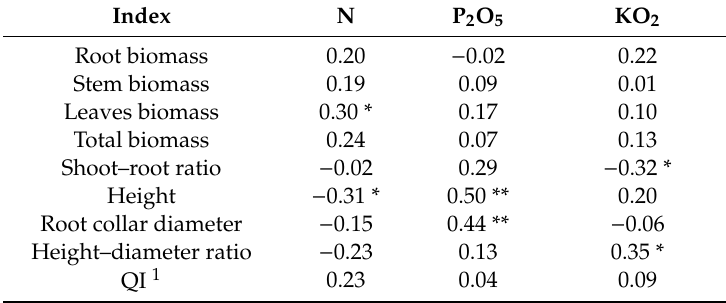
Table 6. Correlation analysis of fertilizer application rate and seedling quality index (QI) value in relation to other plant attributes measured at the end of the trial for Phoebe bournei seedling growth response to the 14 fertilization